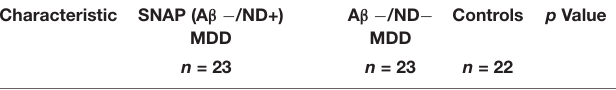
TABLE 2 | Region of interest (ROI) group comparisons among the SNAP MDD, A β − /ND − MDD, and control groups. Characteristic SNAP (A β − /ND+)